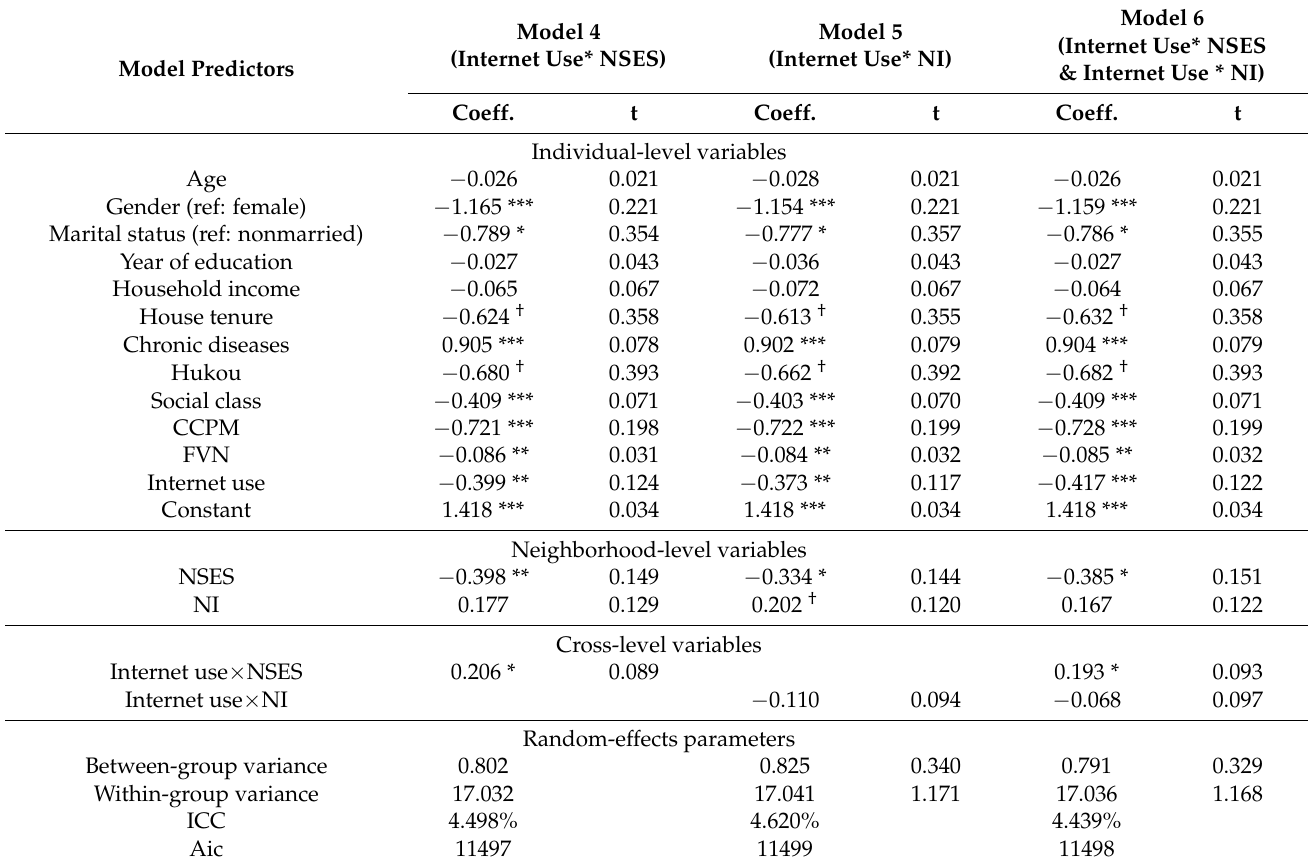
Table 3. The cross-level interaction models on mental distress, Internet use, and neighborhood